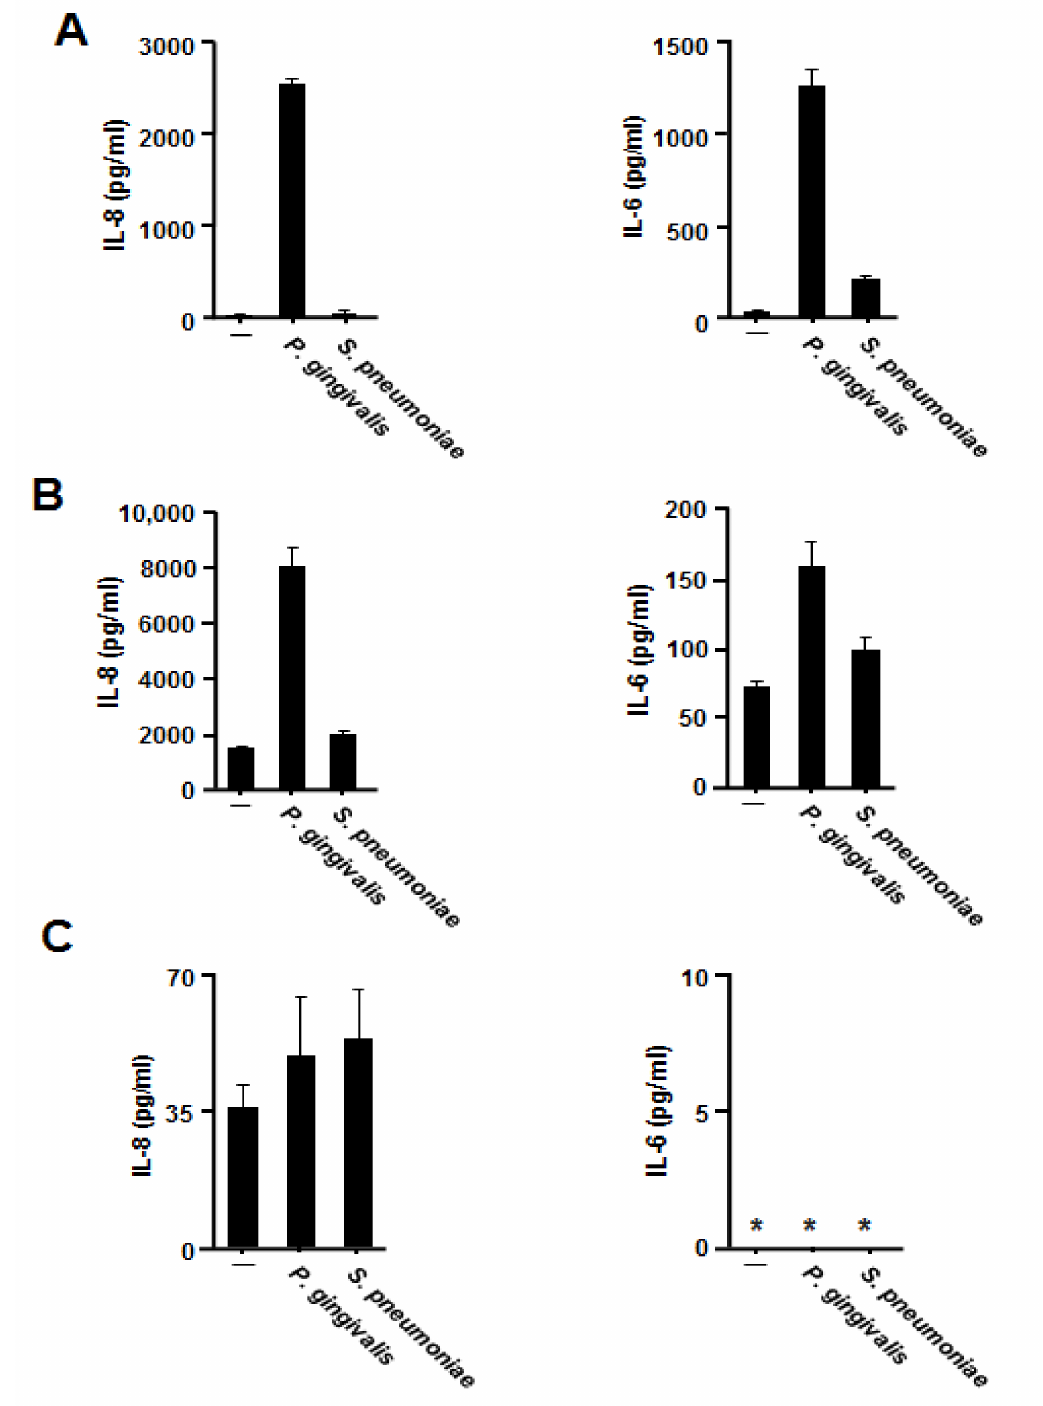
Figure 3. Comparison between the induction of proinflammatory cytokines by Porphyromonas gingivalis and by Streptococcus pneumoniae . BEAS-2B ( A ), Detroit 562 ( B ) or A549 ( C ) cells were incubated in the presence of heat-inactivated cells (1 × 10 8 CFU / mL) of P. gingivalis or S. pneumoniae for 12 h. IL-8 and IL-6 levels in the culture supernatants were then determined using enzyme-linked immunosorbent assay. These experiments were performed in triplicate, and data are presented as the mean ± SD. *; below the detection